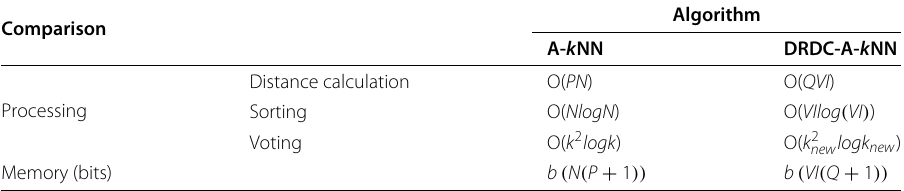
Table 2 Complexity comparison of A- k NN and DRDC-A- k NN AMC classifiers. k new is the selected new k after DRDC, which is equal to the least integer greater than